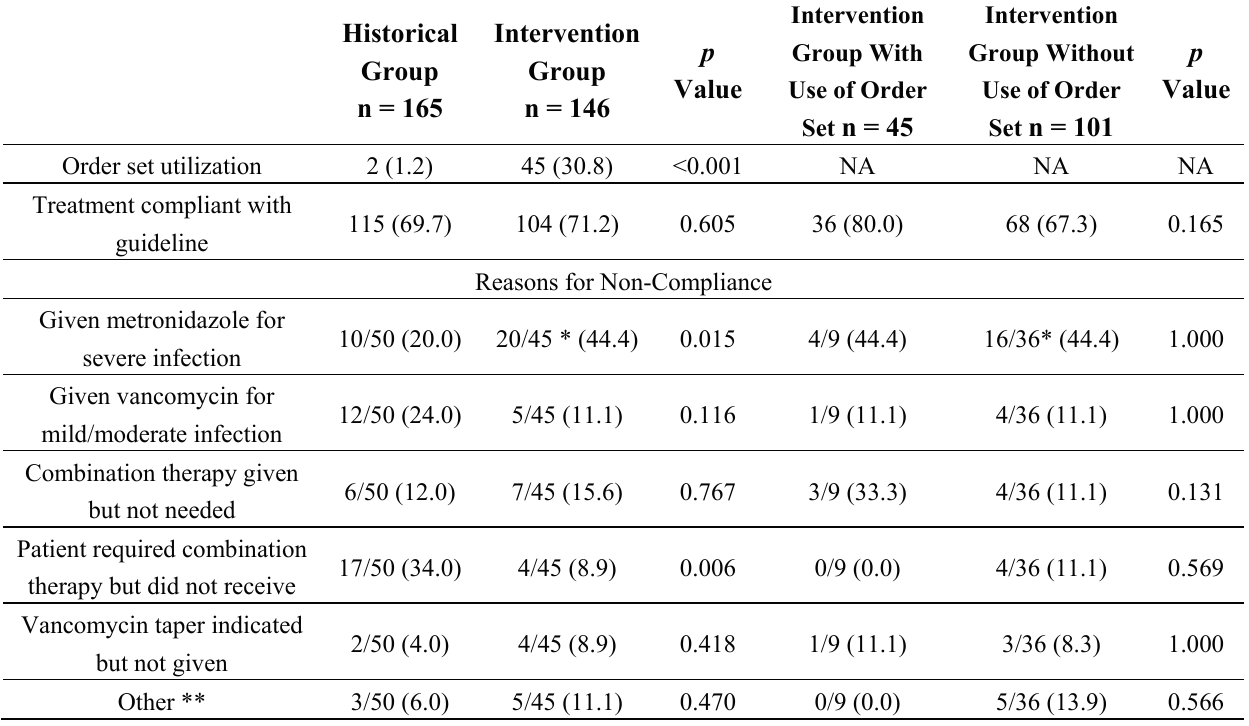
Table 2. Guideline Compliance and Order Set Utilization.